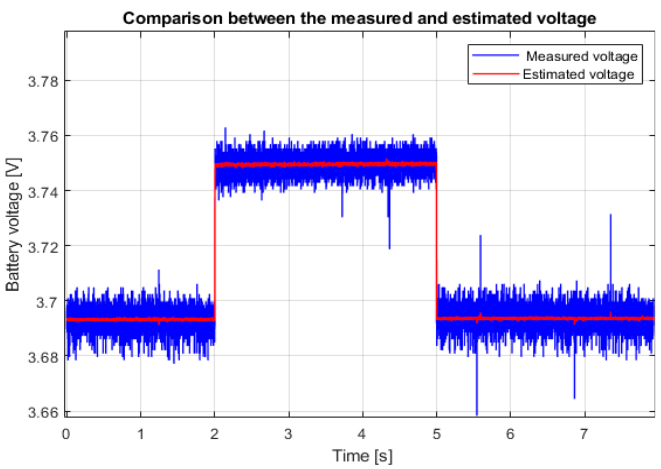
Figure 7. Measured and model of calculated voltage according to estimated parameters. Table 2 . Reference table of learned values .